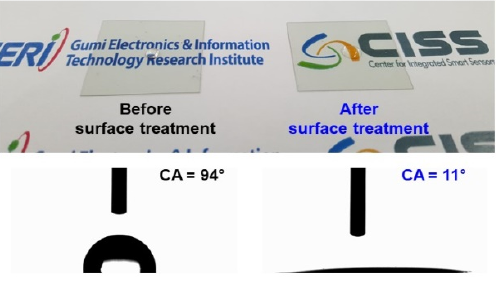
Figure 5. Photograph and contact angle (CA) images of deionized (DI) water droplets on the surface (PET-side) of the flexible transparent heater before and after surface treatment with O 2 plasma.